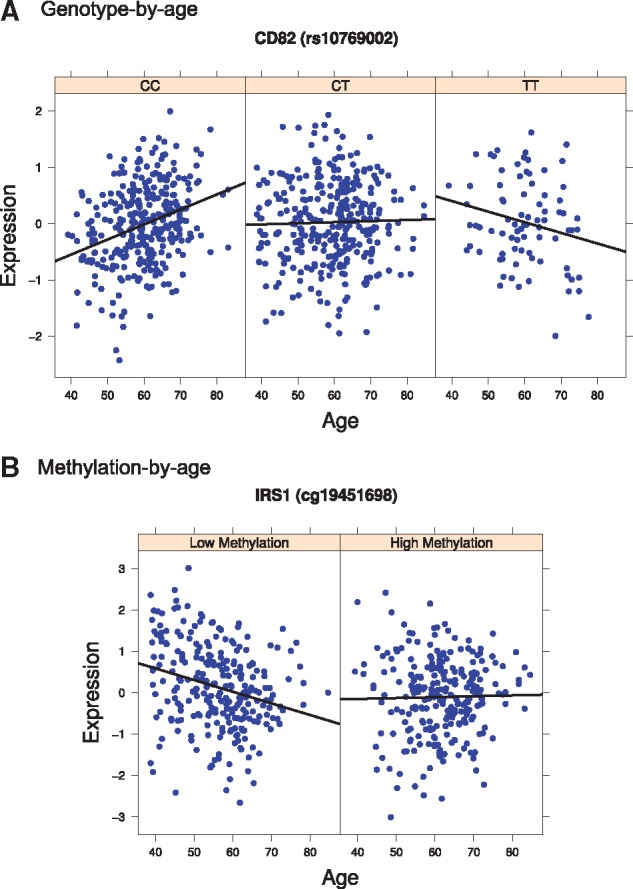
Interacting effects of aging on gene expression: The two plots show the effects of genotypes (eQTL) and methylation on gene expression can be modulated by age. (A) The graph shows a genotype-by-age expression quantitative trait locus (GxAge-eQTL) in fat tissue affecting the expression of the CD82 gene. The expression of the reported exon increased with age in homozygous individuals for the CC alleles in rs10769002. Homozygous individuals for the alternative allele (TT) showed a decreased in expression with age. (B) The graph shows a methylation-by-age interaction affecting gene expression. The expression of the IRS1 gene decreased with age in individuals with the methylation cg19451698 hypomethylated.